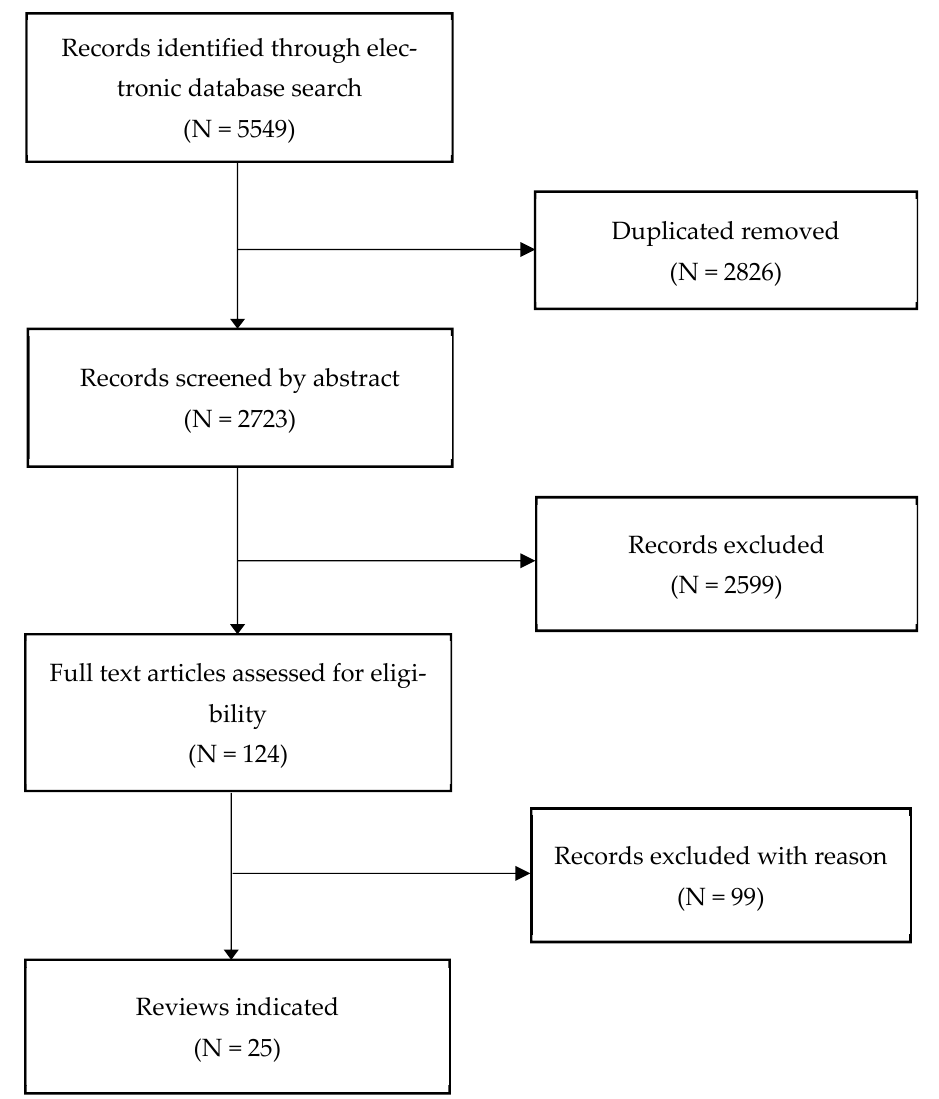
Figure 1. Search flow.